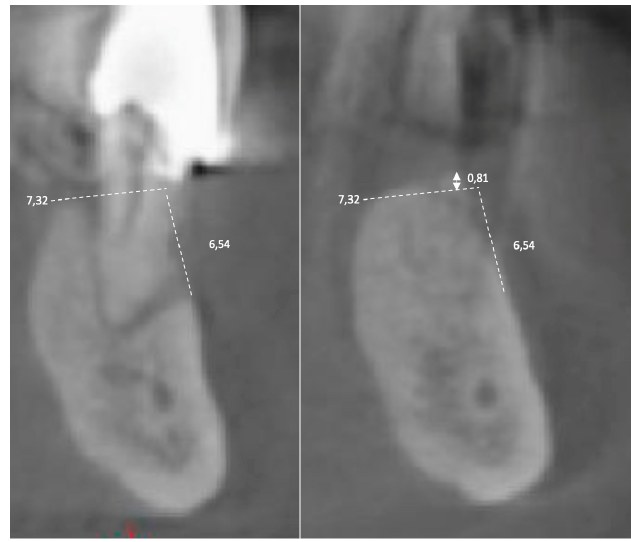
Figure 3. The superimposition of these two CBCT sections allows seeing the regeneration was 0.81 mm greater than expected.